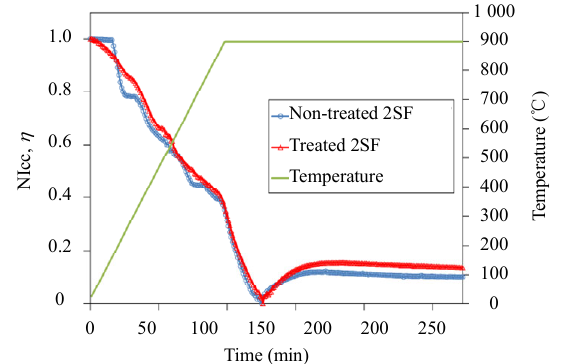
Fig. 3 Reflectivity curves of the non-treated and treated fibers during thermal regeneration process in terms of normalized integrated coupling coefficient (NICC), η